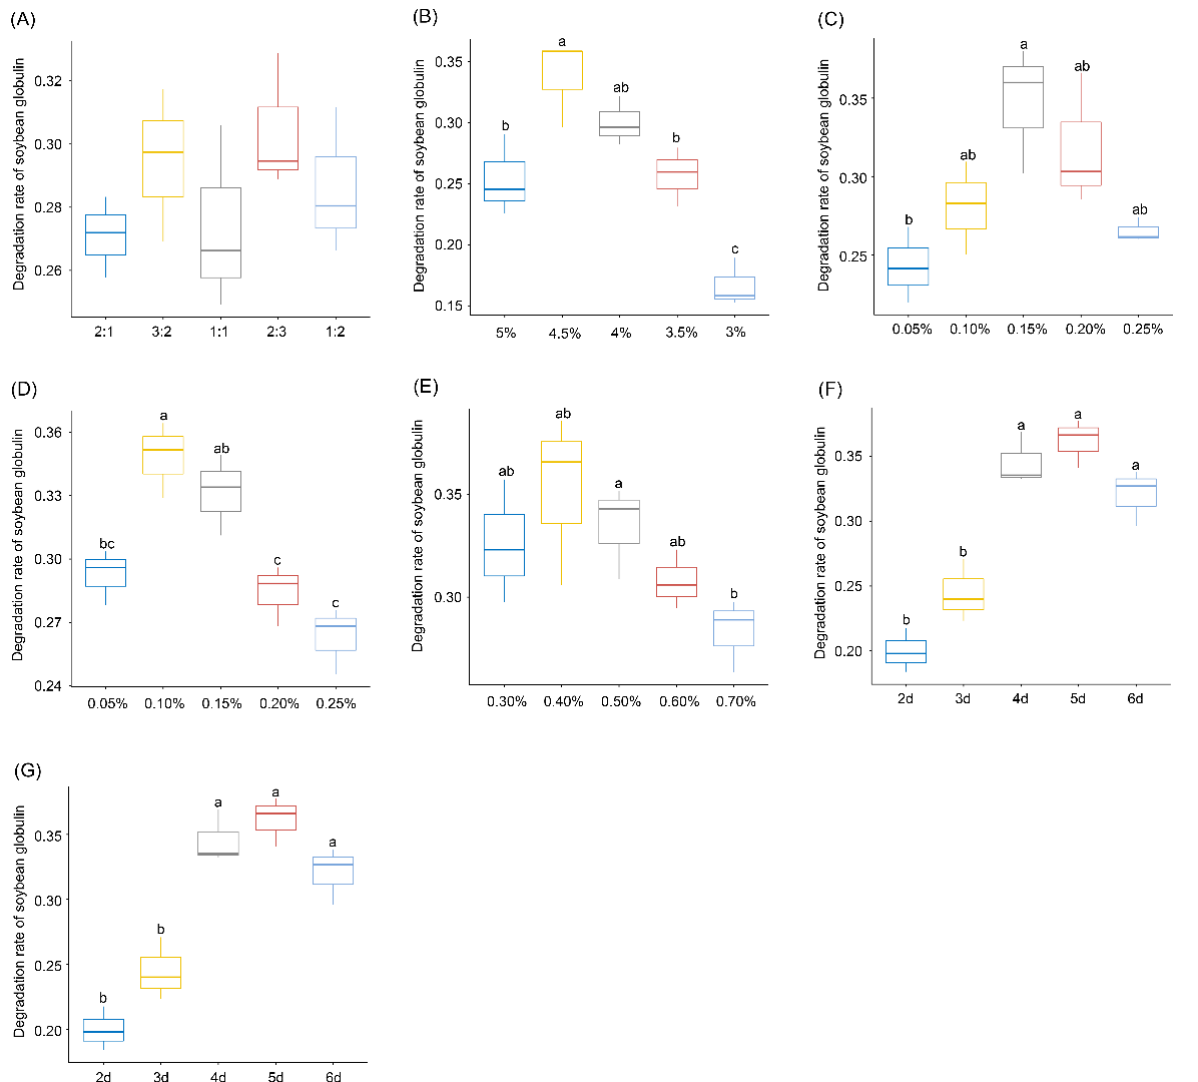
Figure 1. Effects of different fermentation conditions on the degradation rate of soybean globulin (DRSG) in fermented soybean meal (FSM). ( A ) Effect of the proportion of Bacillus subtilis X ‐ 2 and Enterococcus faecium X ‐ 4 on the DRSG in FSM; ( B ) Effect of glucose addition on the DRSG in FSM; ( C ) Effect of KH 2 PO 4 addition on the DRSG in FSM; ( D ) Effect of MgSO 4 ∙ 7H 2 O addition on the DRSG in FSM; ( E ) Effect of anhydrous sodium acetate on the DRSG in FSM; ( F ) Effect of fermenta ‐ tion time on the DRSG in FSM; ( G ) Effect of solid water ratio on the DRSG in FSM. The difference in the lower ‐ case letters above the boxes indicates that there was a significant difference between the two groups ( p < 0.05).